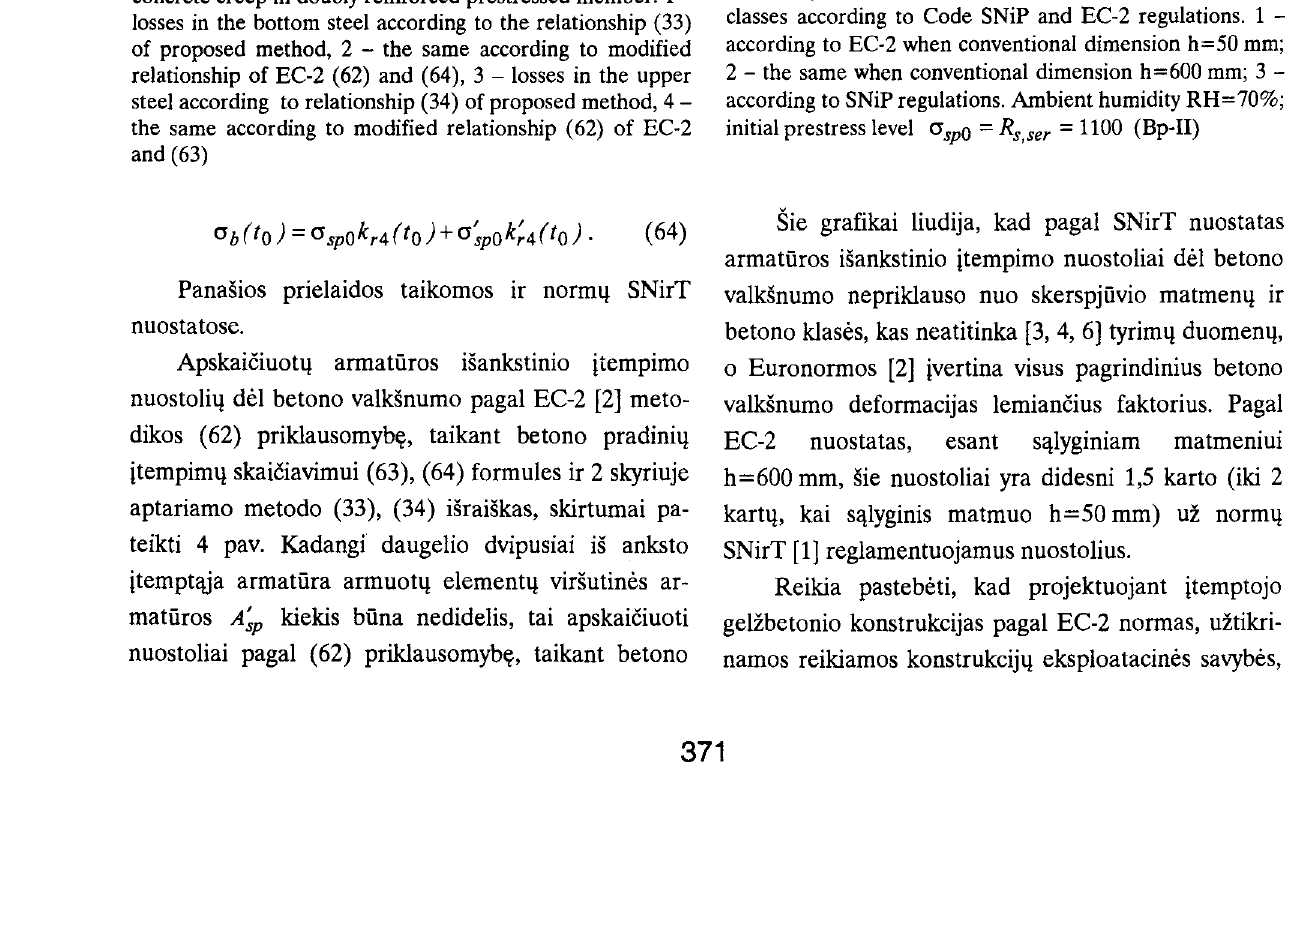
Fig 5. Predicted steel prestress losses due to concrete creep after 70 years for concrete of B20(C16/20) - B60(C50/60) classes according to Code SNiP and EC-2 regulations. 1 - according to EC-2 when conventional dimension h=SO mm; 2- the same when conventional dimension h=600 mm; 3- according to SNiP regulations. Ambient humidity